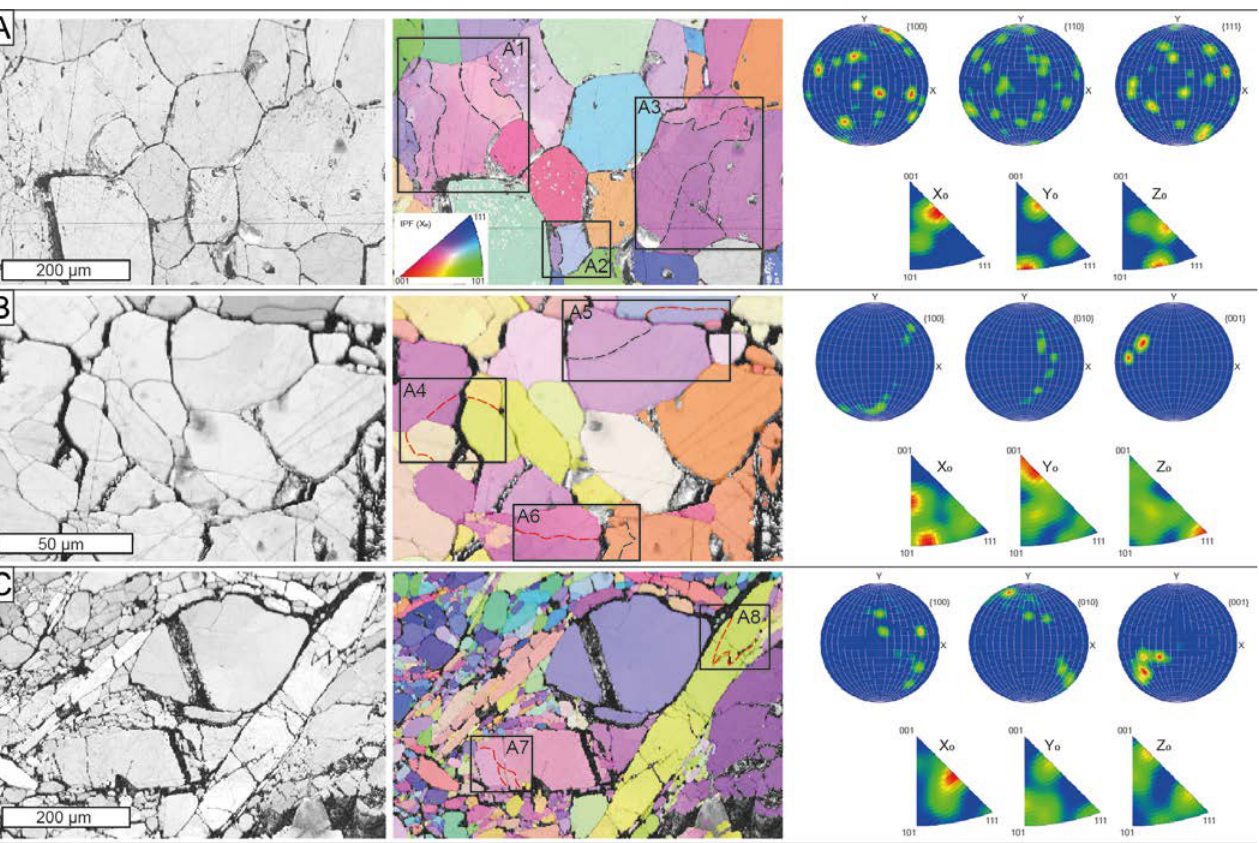
Figure 12. Ore microstructures from the El Robledal. The data are presented using band contrast maps (left) combined with a color-coded inverse pole figure (center), representing the crystal orientation relative to the X0, and the pole figures (right) represent the crystallographic preferred orientation relative to (001). The misorientation angles between the crystal orientation of neighboring data points were grouped into (1) low-angle boundaries, with misorientation lower than 5 ◦ (dashed, black lines), and (2) medium-angle boundaries, with misorientation of 5–10 ◦ (dashed, red lines). ( A ) Massive Mg-rich magnetite sample with 120 ◦ triple junctions. The IPF maps show grains with internal crystal bending (rectangles A1 to A3) that coexist with grains free of deformation. The sample shows near-random to weak patterns of CPO with numerous orientation maxima at (100), (110), and (111). ( B ) Granoblastic ludwigite sample with 120 ◦ curved junctions. Note the higher misorientation angles in the deformed grains compared to A (rectangles A4 to A6). This sample exhibits a strong CPO pattern, especially at (100). ( C ) Porphyroclastic ludwigite with elongated and deformed grains surrounding nondeformed porphyroclasts. The elongated grains show the highest misorientation degrees (rectangles A7-A8) Note the similar size of the neoblast compared to subgrains developed on deformed ludwigite porphyroclasts (rectangle A7). The pole figure shows a strong CPO pattern, especially at